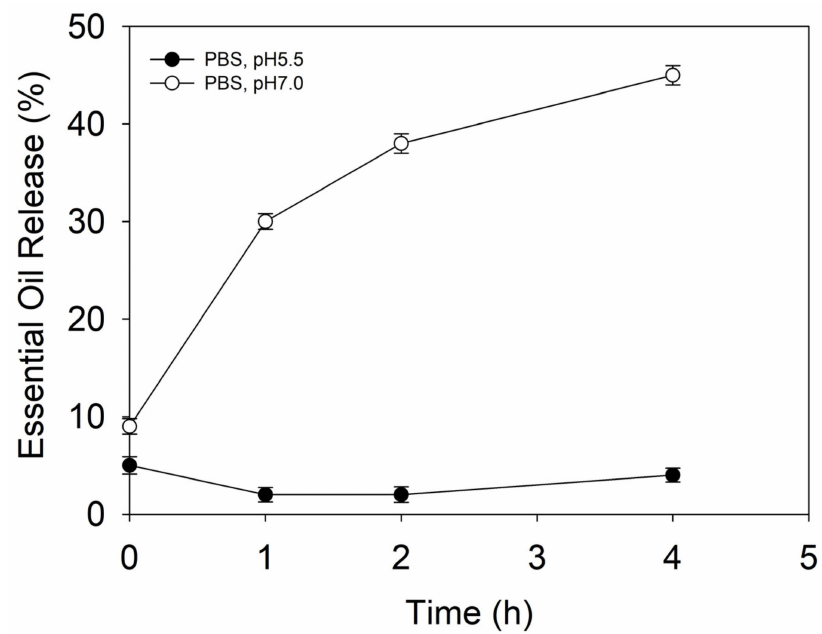
Figure 2. EO release from the NCs under conditions mimicking healthy skin (pH 5.5) and conditioned skin (pH 7) promoting acne vulgaris